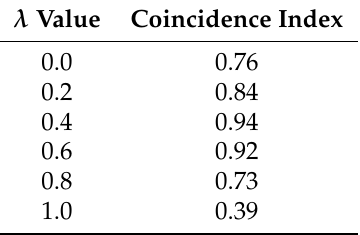
Table 9. Coincidence index values comparing the output of BIOLP for the reference scenario and for scenarios using different values for the λ parameter (all weights were fixed to